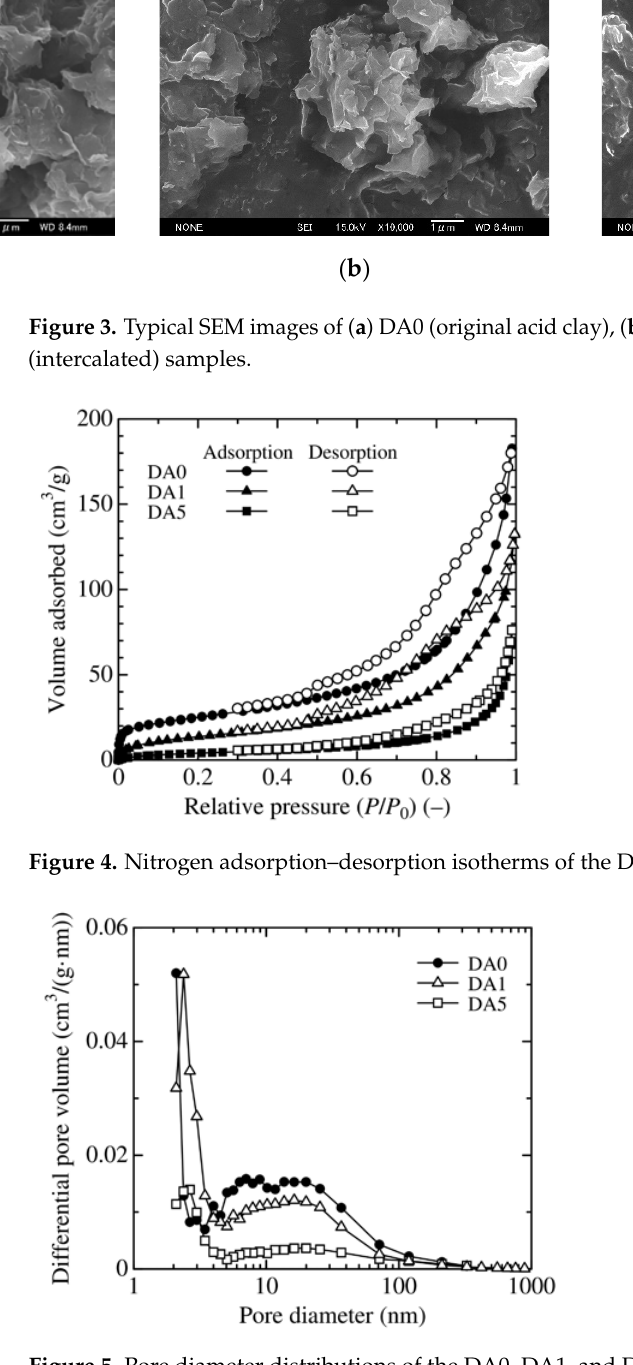
Figure 5. Pore diameter distributions of the DA0, DA1, and DA5 samples. Table 2. Specific surface area, pore volume, and pore diameter of the DA0, DA1, and DA5 samples.